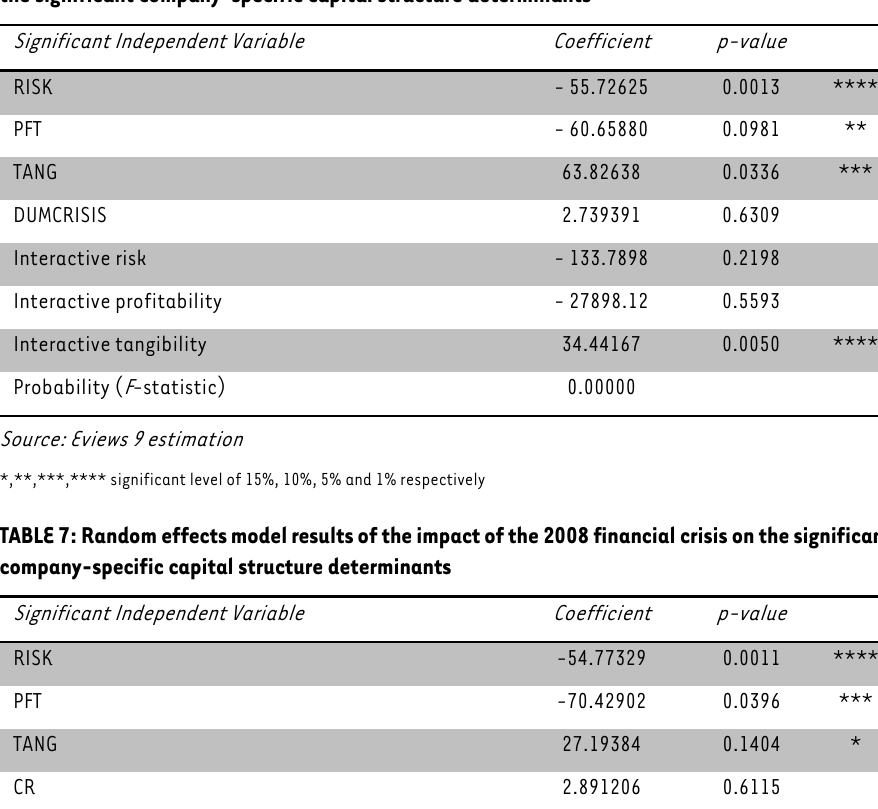
TABLE 6: Fixed effects cross-sectional model results on the impact of the 2008 financial crisis on the significant company-specific capital structure determinants